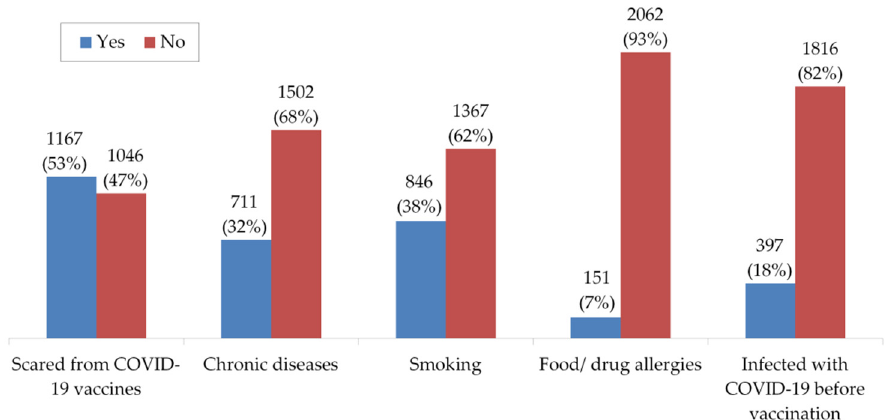
Figure 2. The readiness and health status of participants before getting vaccinated for COVID-19.